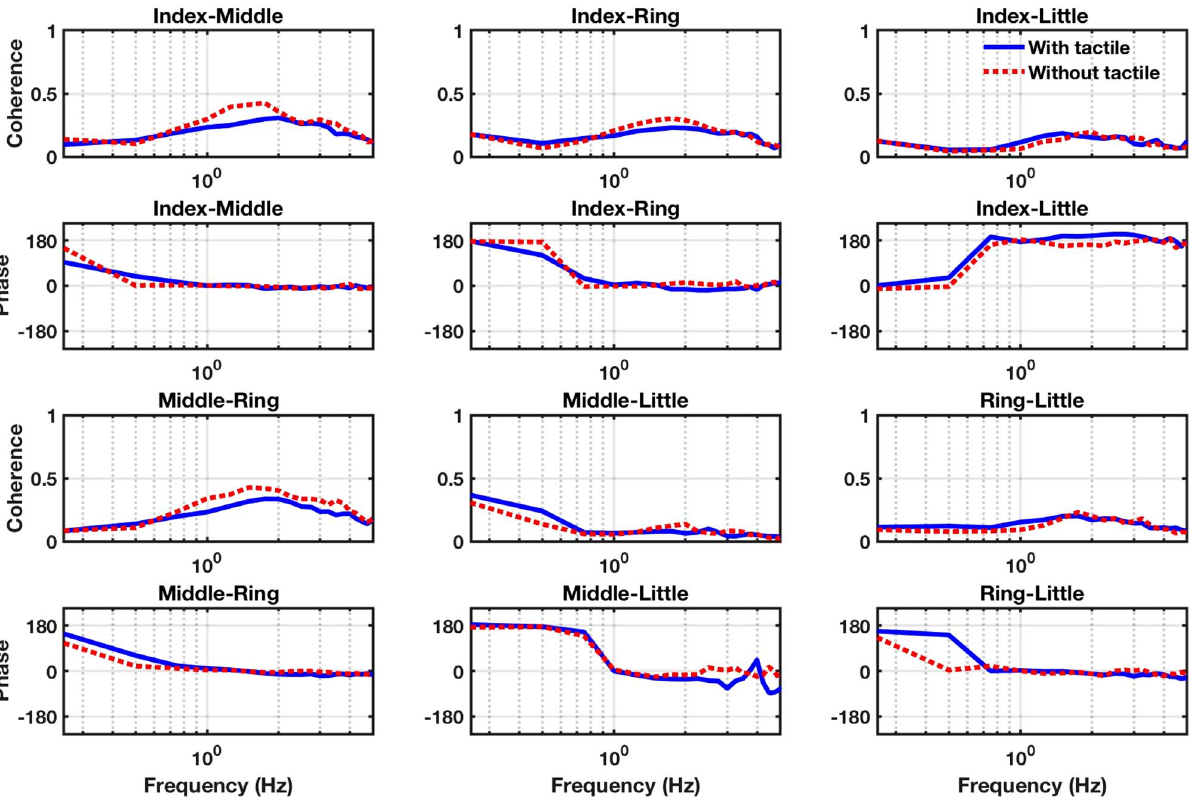
Figure 4. Complex coherence. Squared magnitude and phase of coherence for combinations of finger forces (index-middle, index-ring, index-little, middle-ring, middle-little, and ring-little) are shown. Blue and red lines correspond to tactile and no tactile feedback conditions,